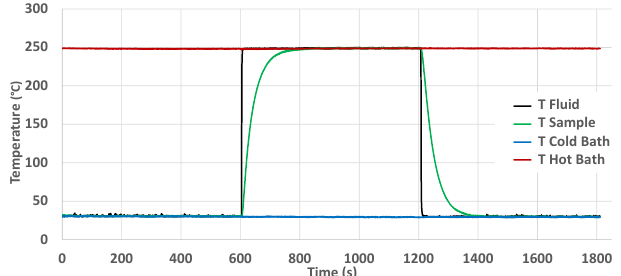
Fig. 7 Temperatures versus time for a test with a propeller velocity of 1000 rpm and with hot and cold temperatures of 250 °C and of 31 °C respectively.